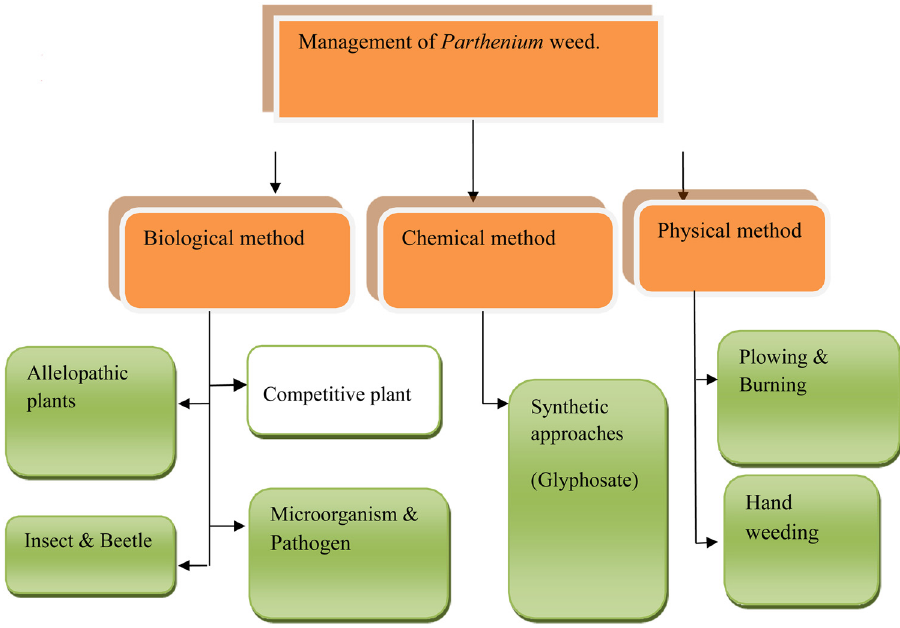
Figure 1: Schematic representation of the management of P. hysterophorus